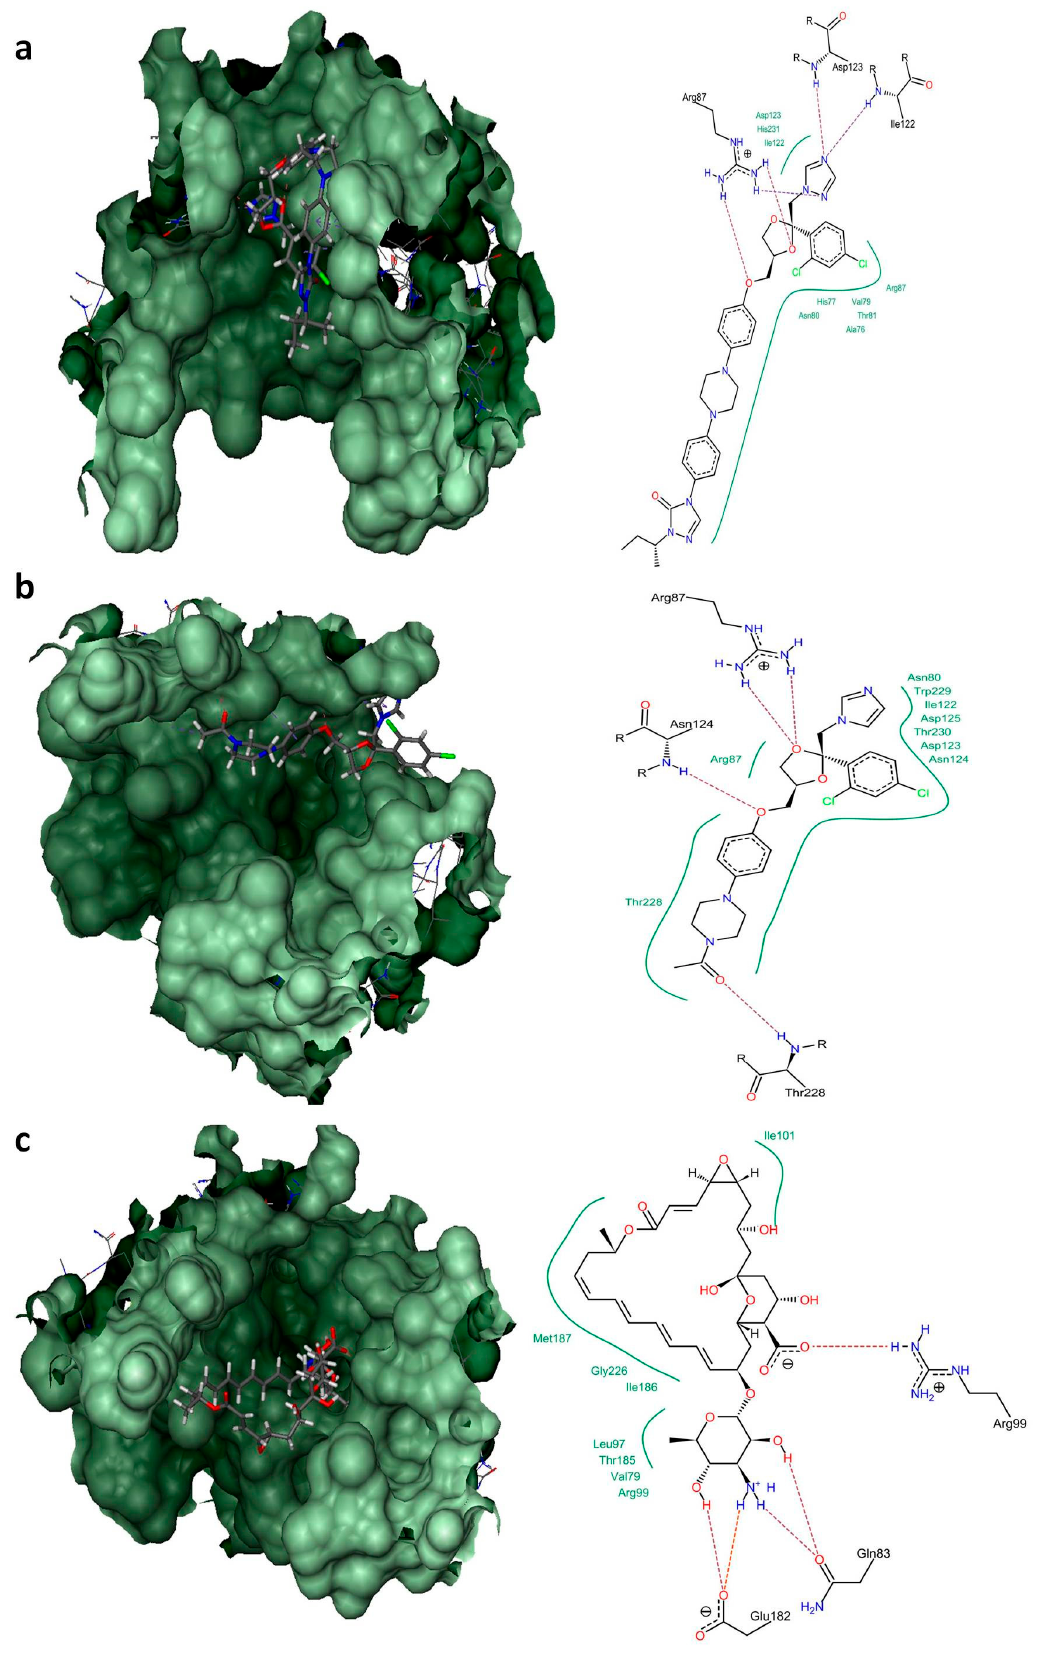
Figure 4. The docking complex and interactions of the best docked compounds with RNAP from A. flavus . ( a ) Itraconazole (Binding energy: − 22.0427 kJ / mol); ( b ) Ketoconazole (binding